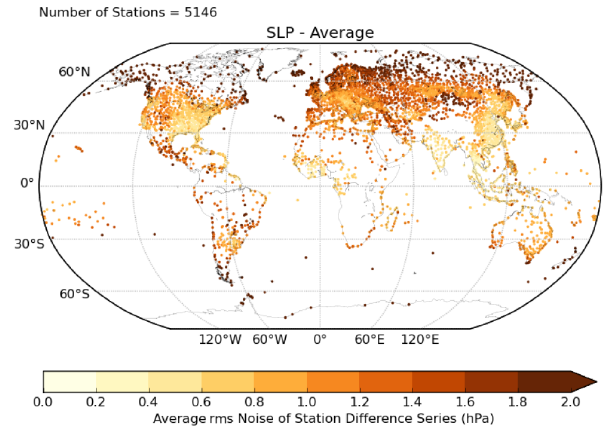
Figure A4. The average rms difference for the neighbours from each station for the monthly-average sea-level pressure.